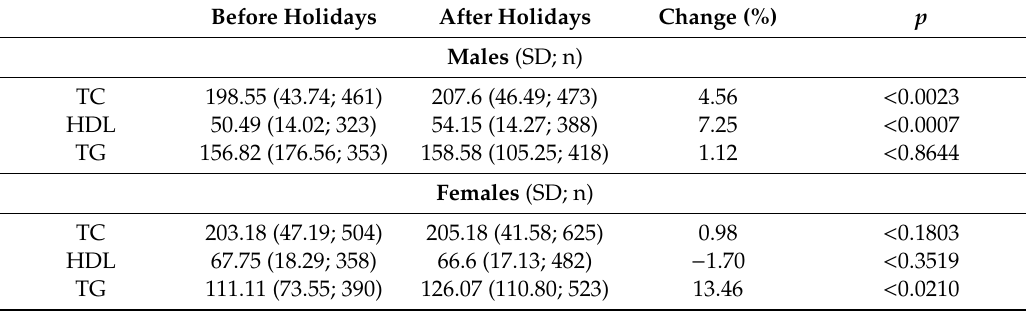
Table 4. Changes (%) in the mean value ( ± SD) of TC, TG, and HDL levels (mg%) for males and females in 4-day periods before and after